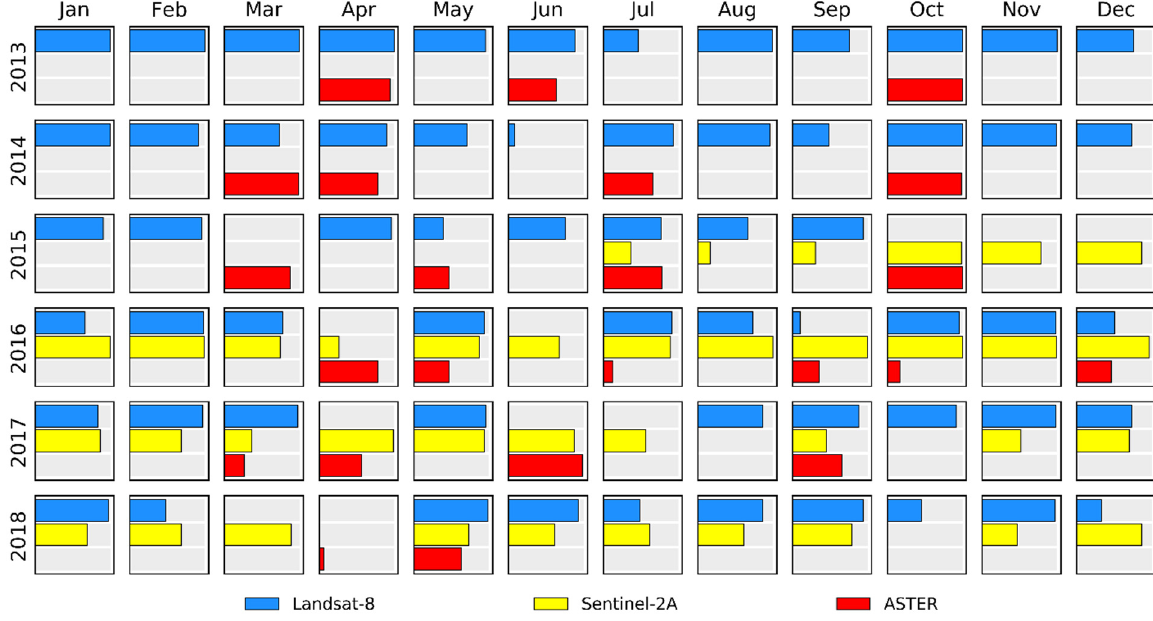
Figure 5. Monthly percentage of visible pixels in the satellite imagery. The gray bars in the background are provided for scale and indicate 100% visibility.